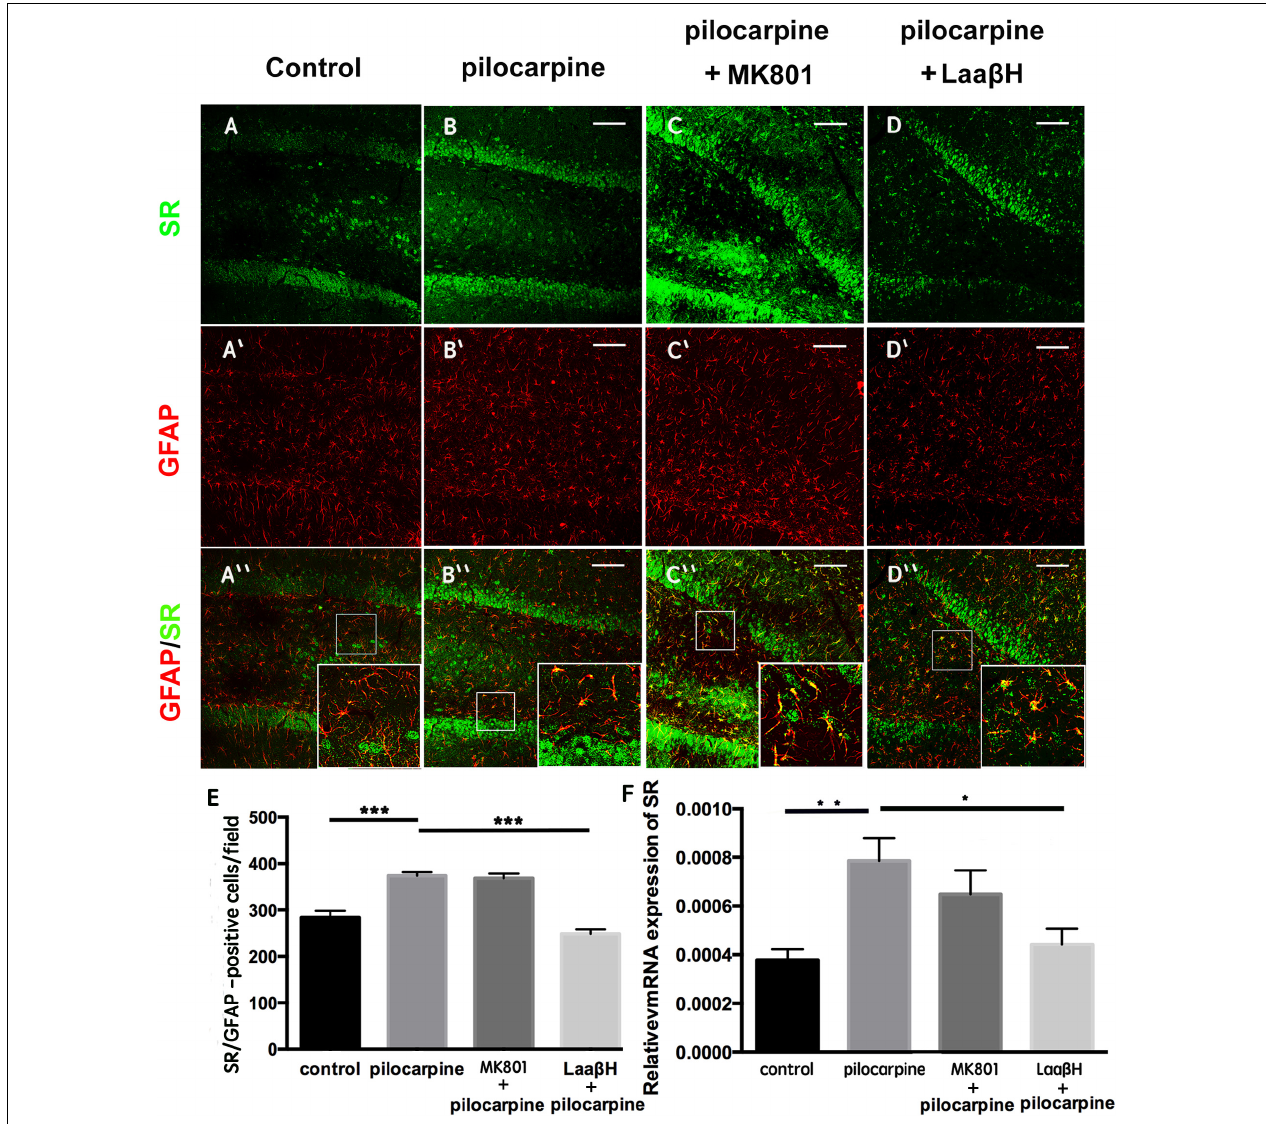
FIGURE 1 | Expression of SR in astrocytes after seizure induction in rats. (A–D) Double immunostaining of GFAP/SR in the hippocampi of control rats (A,A’,A”) , pilocarpine treated rats (B,B’,B”) , pilocarpine + MK801 treated rats (C,C’,C”) , and pilocarpine + Laa β H treated rats (D, D’, D”) . (E) Quantification of SR/GFAP-positive cells in the hippocampi of rats treated with pilocarpine, MK801, pilocarpine + MK801, and pilocarpine + Laa β H. N = 3–5 rats per group. (F) Real-time RT-PCR of SR in the hippocampi of rats treated with pilocarpine, MK801, pilocarpine + MK801, and pilocarpine + Laa β H. N = 3 rats per group. The expression level of SR was upregulated after seizure induction. MK801 had no significant effects on the induction of SR, and Laa β H could inhibit the up-regulation of SR by seizures. ∗ P < 0.05, ∗∗ P < 0.01, ∗∗∗ P < 0.001. Bars = 50 µ m.